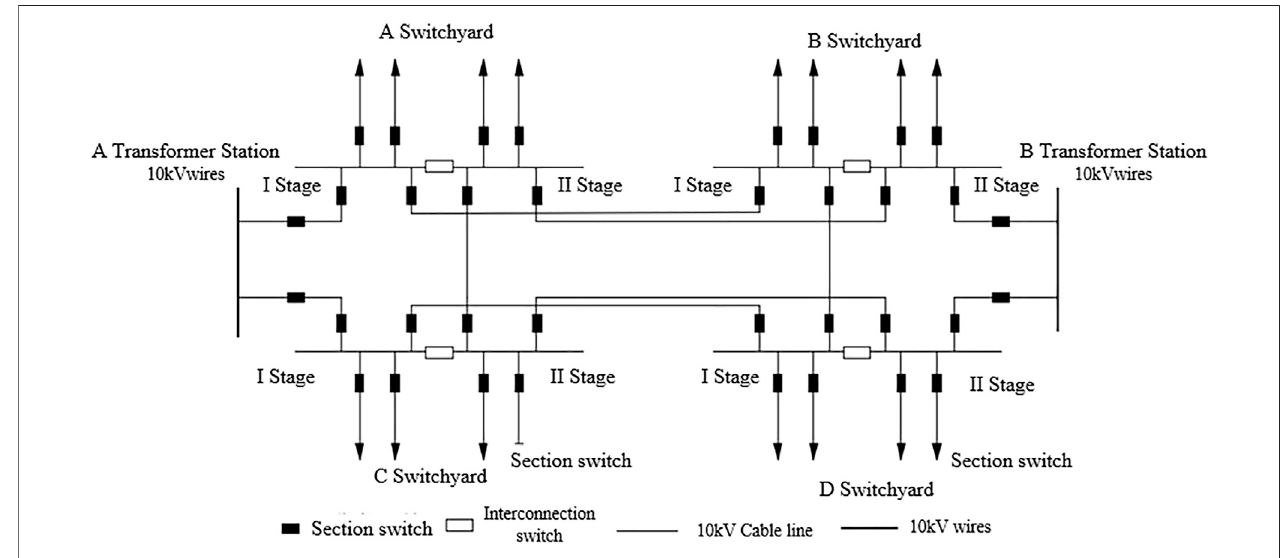
FIGURE 4 | Cable “ double petals ” wiring diagram.